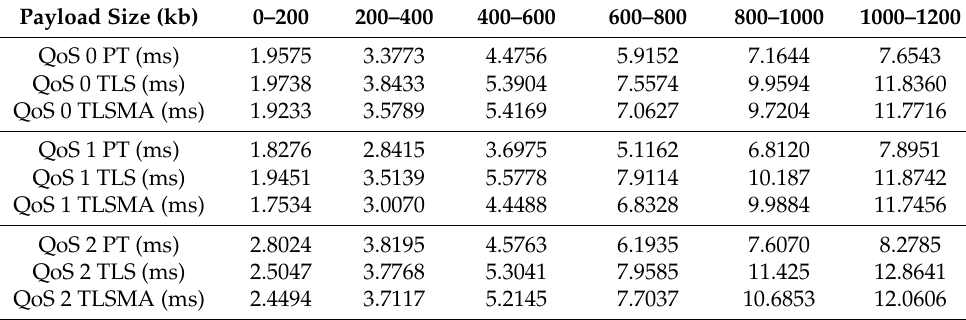
Table 2. Latency for TLS and non-TLs enhanced